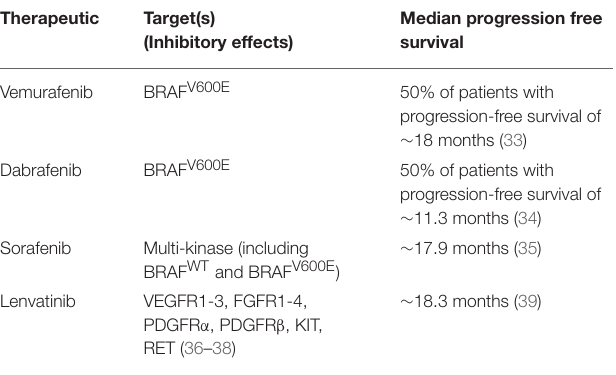
Frontiers in Endocrinology |